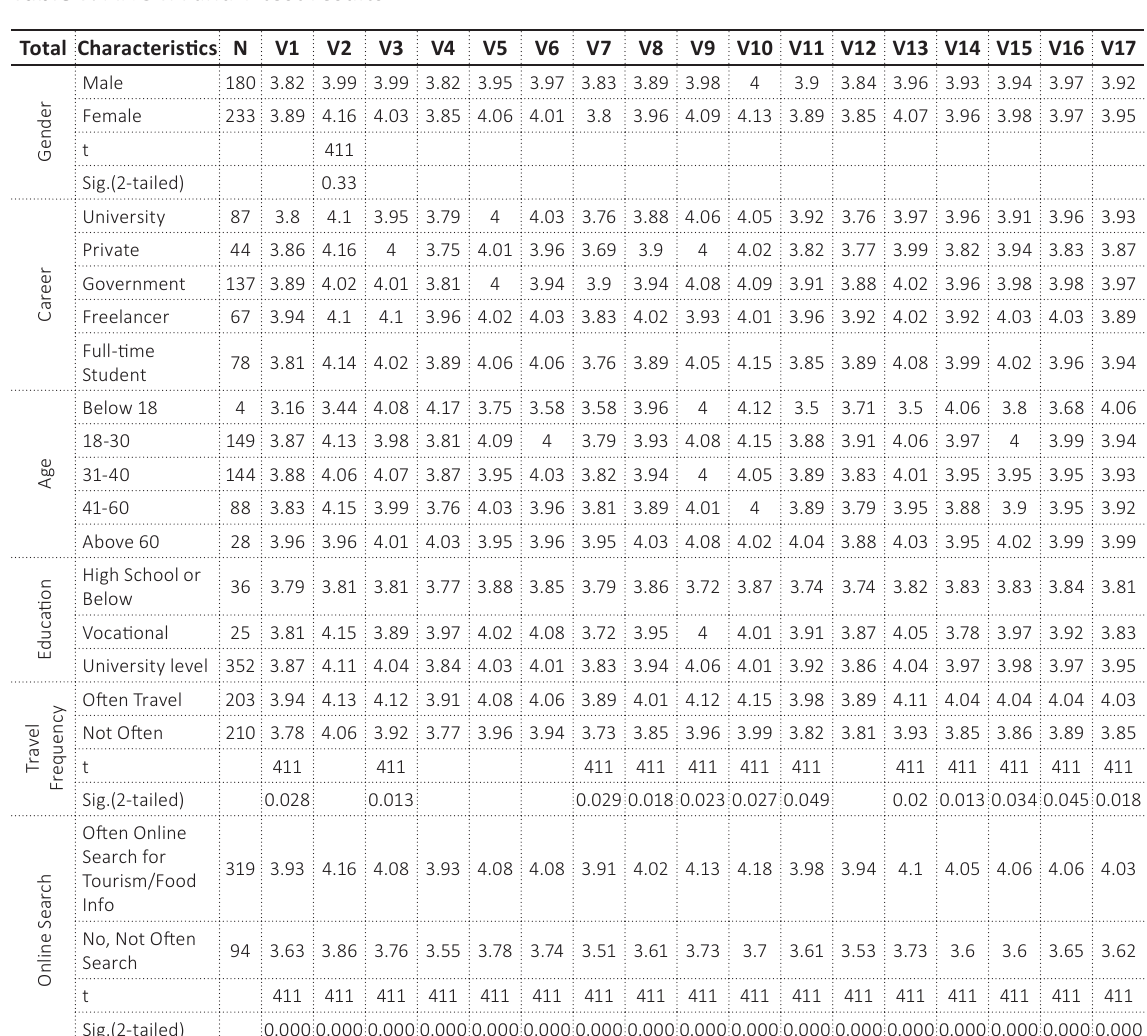
Table 7. ANOVA and T-test results – 1